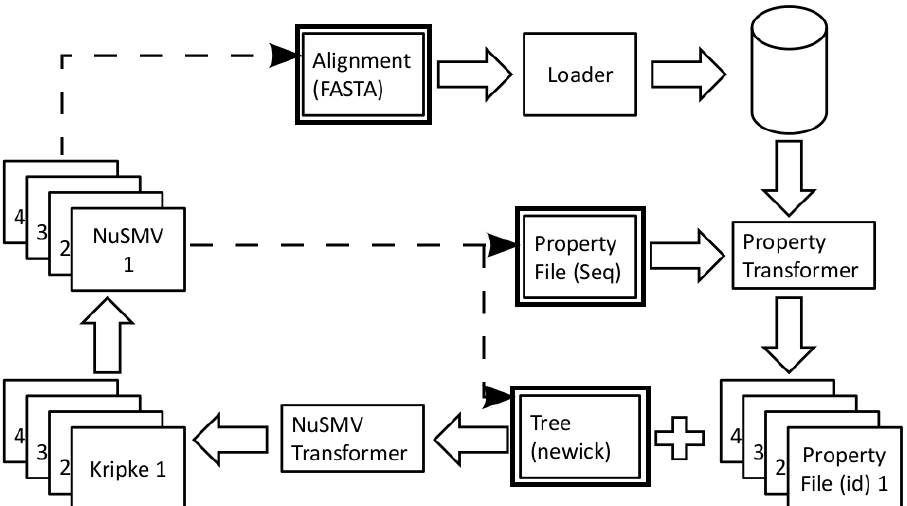
Figure 2: Workflow diagram with the alignment, phylogenetic tree and properties as input.